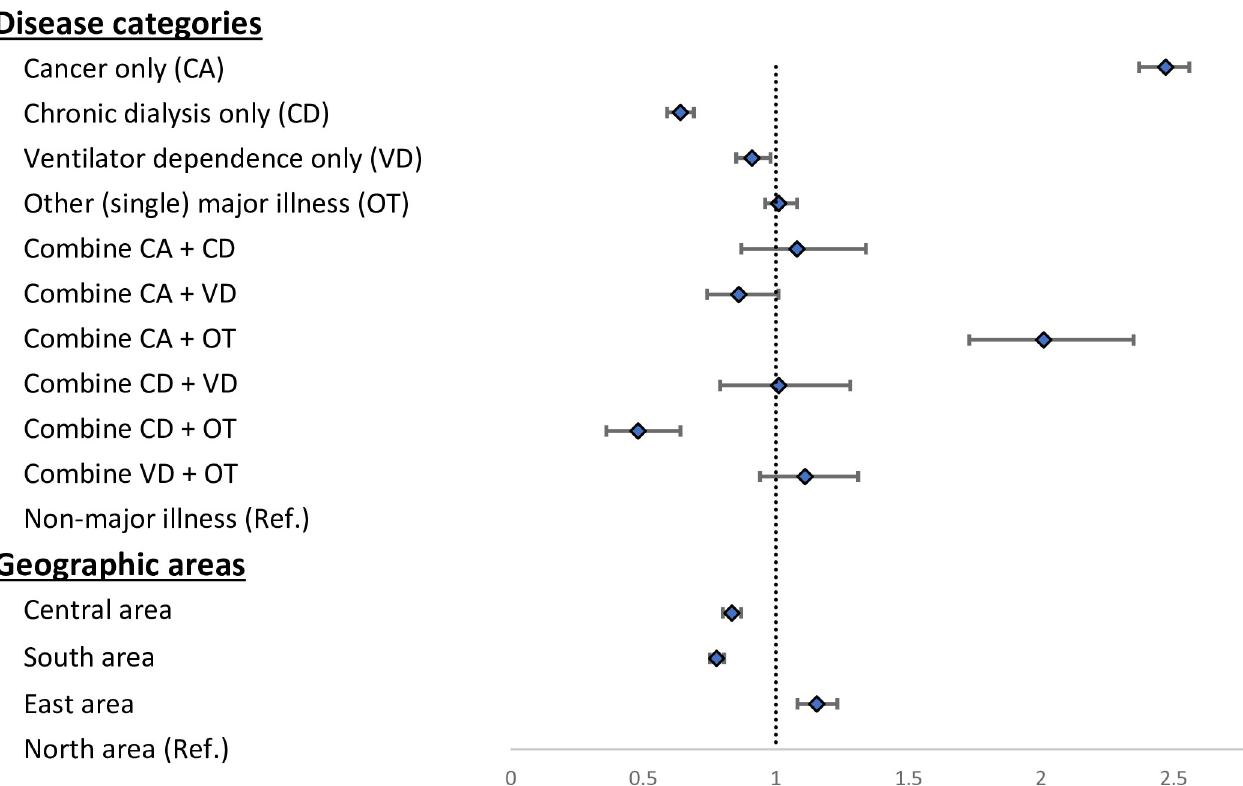
Fig 3. Forest plot: Adjusted odds ratios (aOR) of do-not-resuscitate (DNR) rates among different and combined major illnesses and geographic areas.